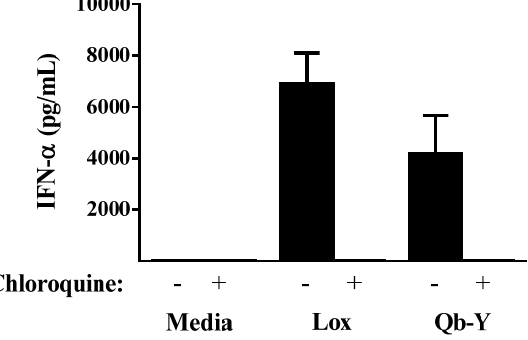
Figure 1. Stimulation of IFN- α secretion in human PBMCs. Cultured cells were stimulated with either 300 µ M loxoribine or 75 µ g/mL of Qb-Y in the absence or presence of 10 µ M chloroquine for 16–20 h. The levels of IFN- α in the supernatants were measured and compared to those obtained with unstimulated cells ( n = 4). The assay’s lower limit of quantification (12.5 pg/mL) was used when the amount of IFN- α was too low to be detected. The results are representative of those obtained from a similar experiment using PBMCs from a second human donor.